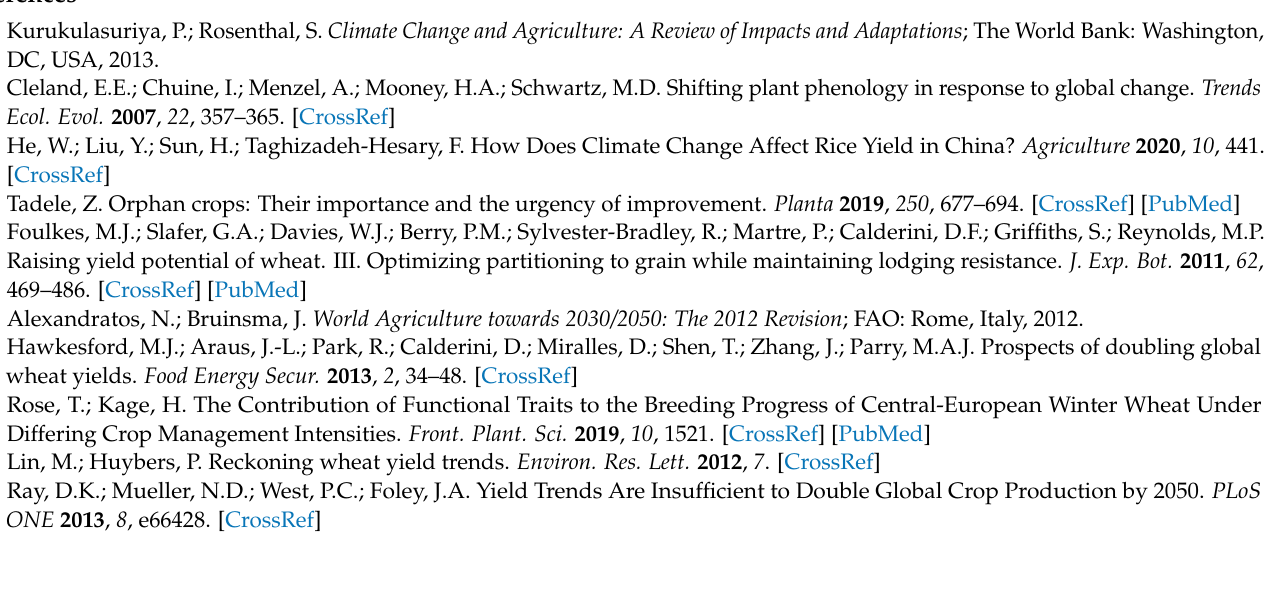
Table S3: Individual location based genotypic (above diagonal) and phenotypic (below diagonal) correlation coefficients of important traits of 320 teff genotypes under the field growing condition, Table S4: Cluster members of the 317 teff genotypes under the intensive growing